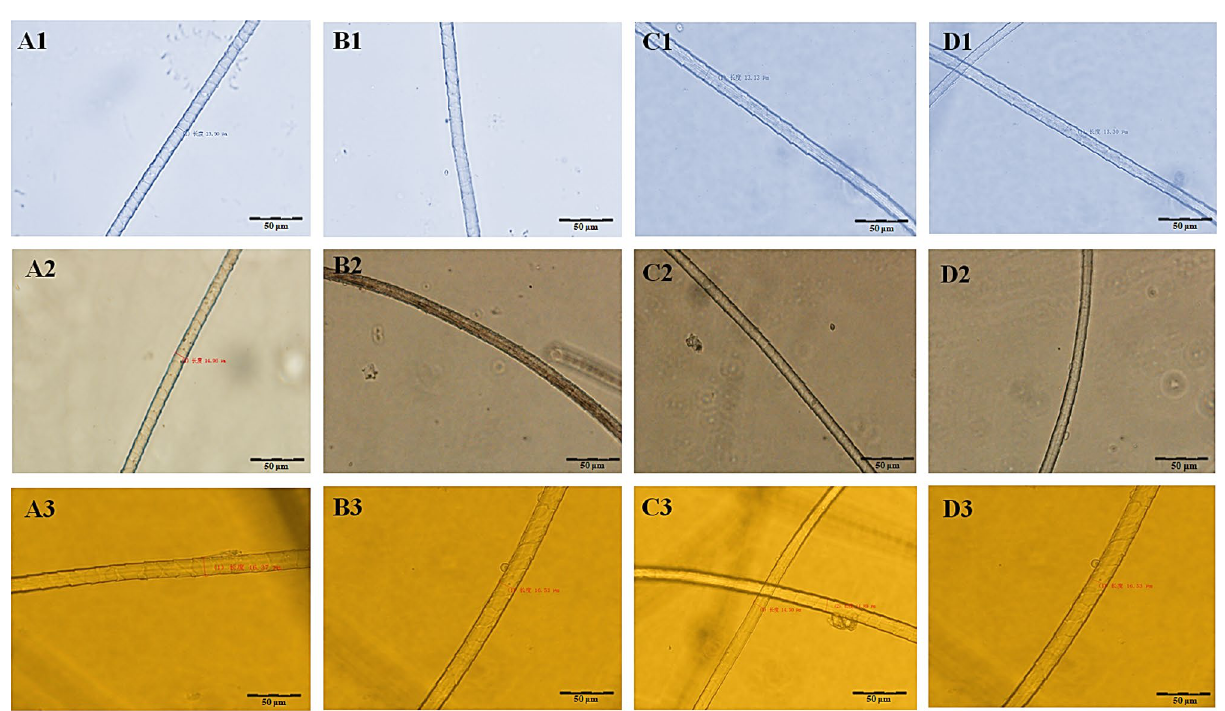
Figure 4. The diameter of cashmere of ( 1 ) Inner Mongolia cashmere goat (IMCG), ( 2 ) Dazu black goat (DBG) and ( 3 ) IMCG x DBG (F 1 ) for (A) shoulder, (B) side-portion, (C) abdomen and (D) leg